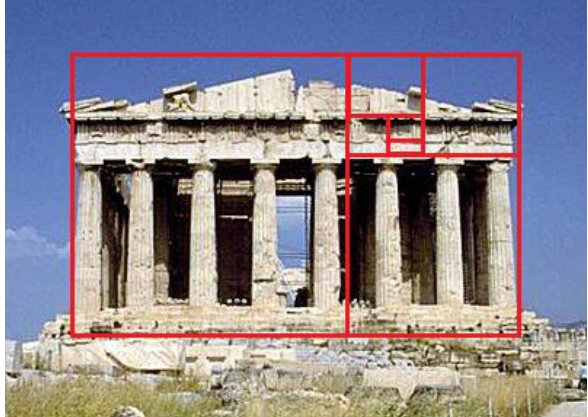
Fig. 3 The Parthenon (Athens, V century b.C.)